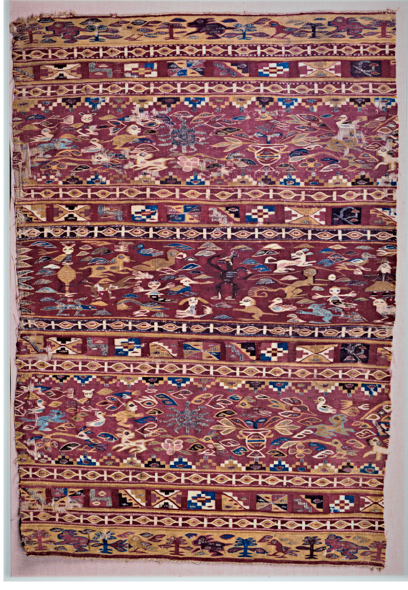
Figure 9 . Wedding cloak, southern Andes, 17th century(?), Roemer- und